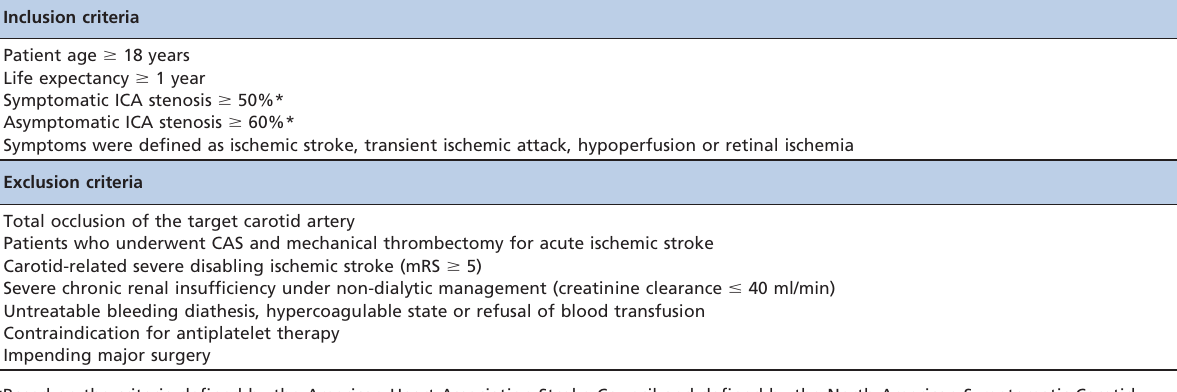
Table 1 - Eligibility